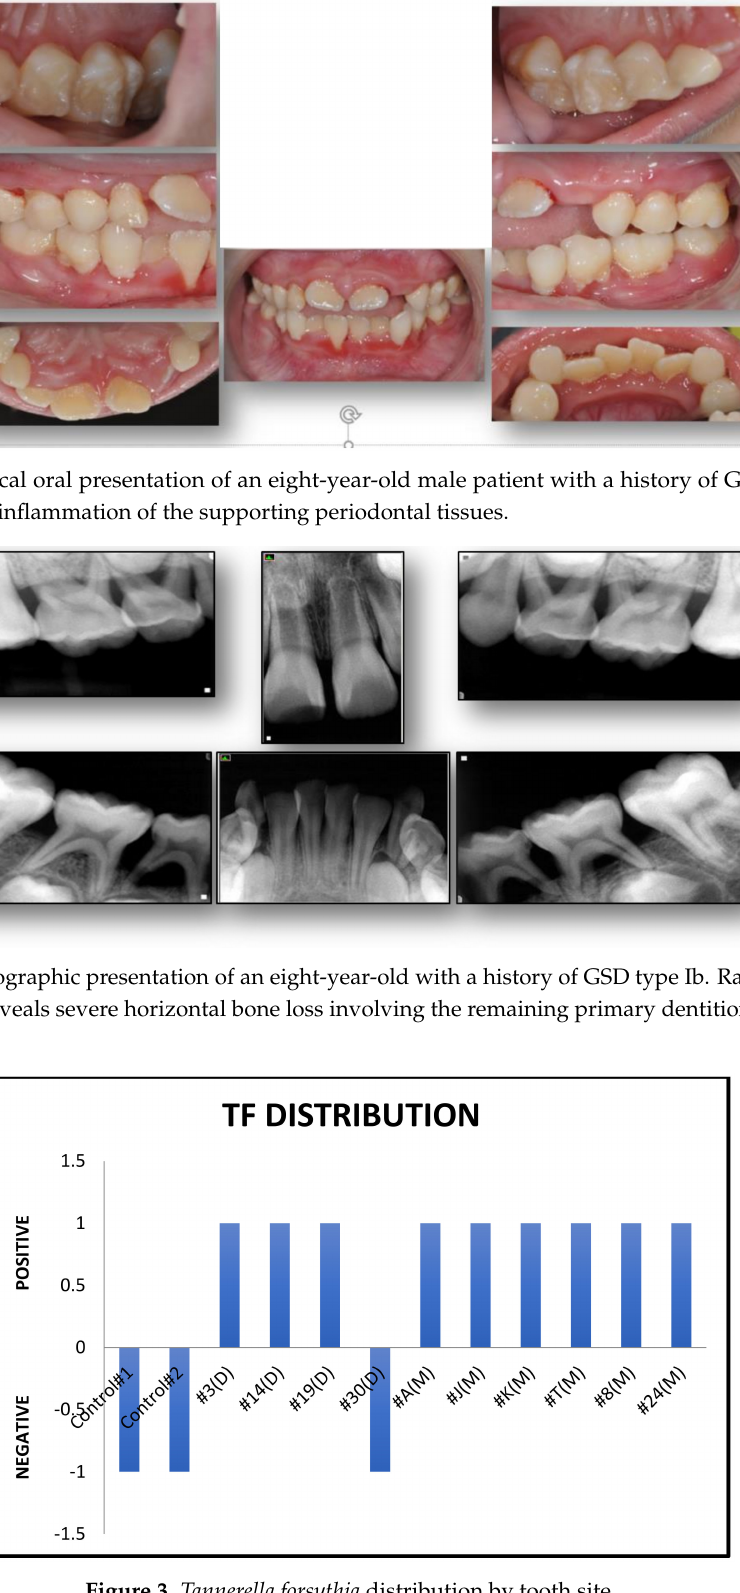
Figure 3. Tannerella forsythia distribution by tooth